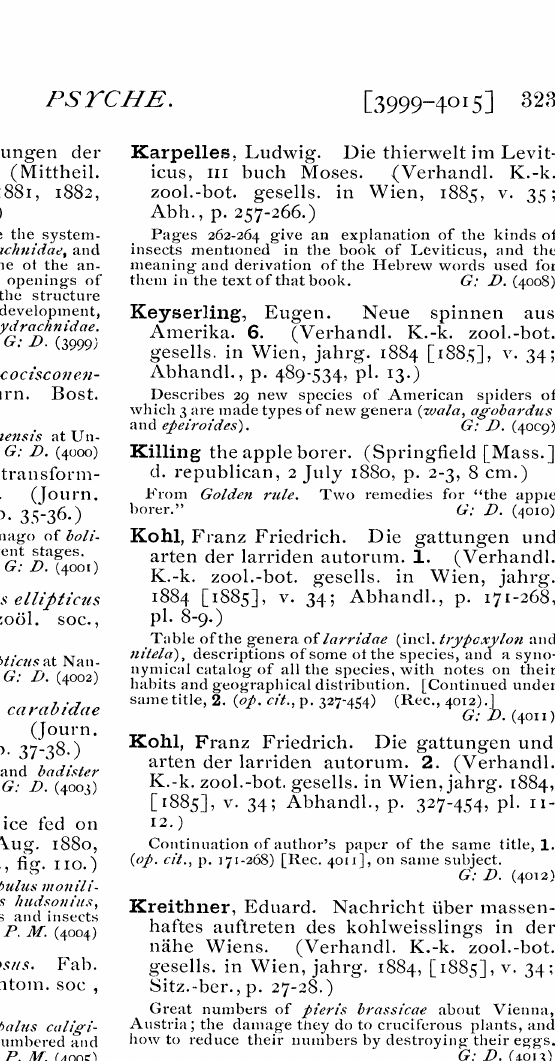
pl.) Colored figure xvith brief description